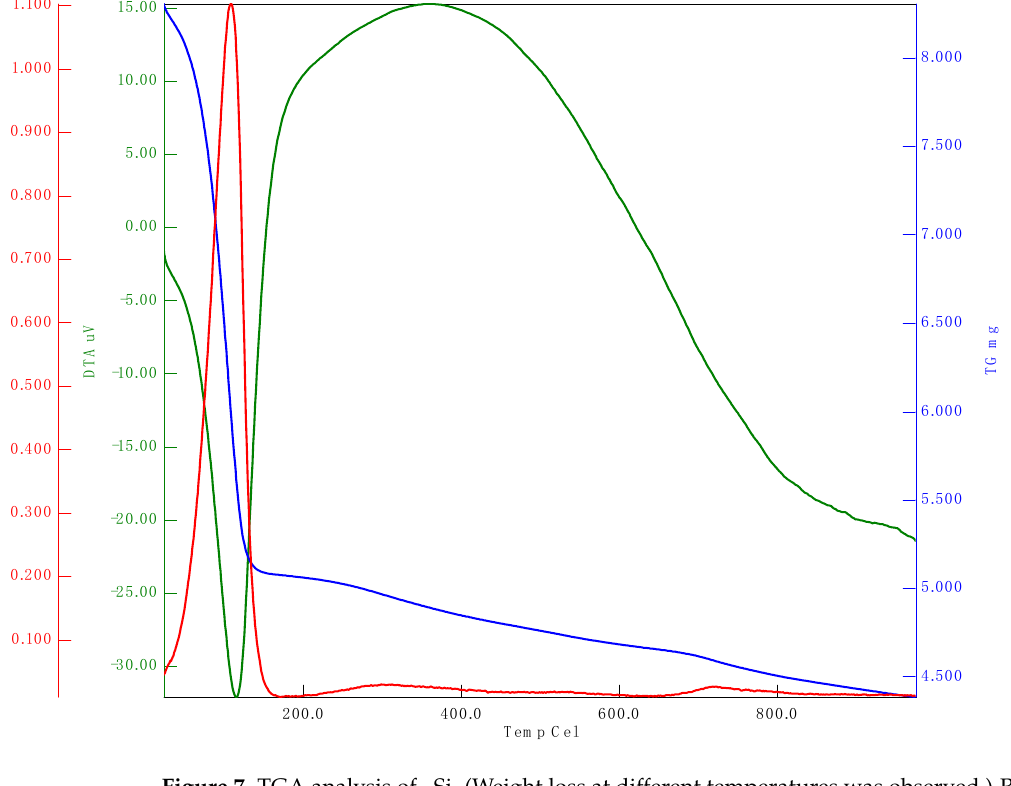
Figure 7. TGA analysis of n Si. (Weight loss at different temperatures was observed.) Red line, DTG; blue line, TG; green line, DTA.